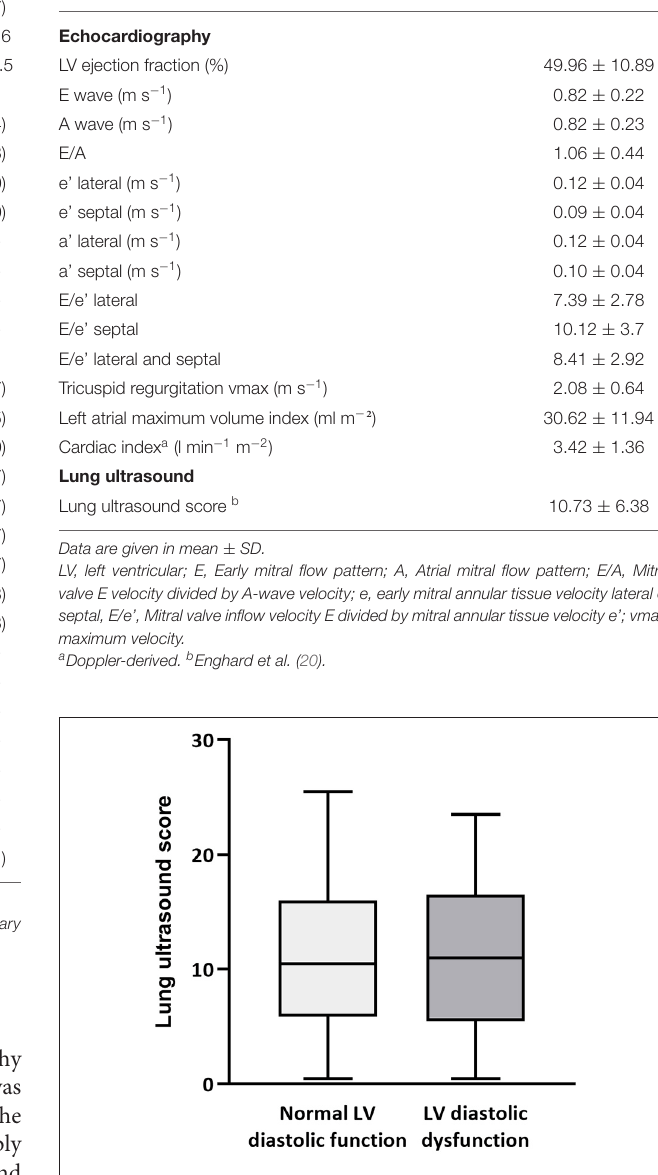
FIGURE 2 | Left ventricular diastolic dysfunction and pulmonary edema. Lung ultrasound score during examinations with normal left ventricular (LV) diastolic function (light gray box) and with LV diastolic dysfunction (dark gray